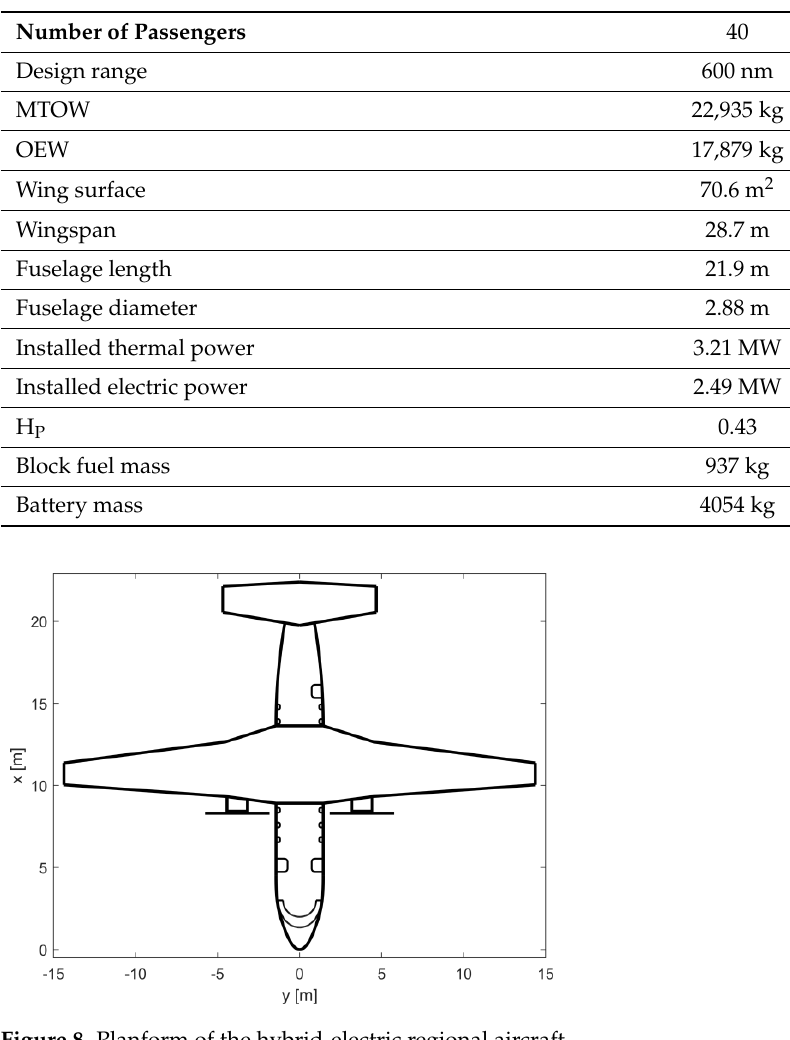
Table 4. Main parameters of the regional hybrid-electric aircraft.